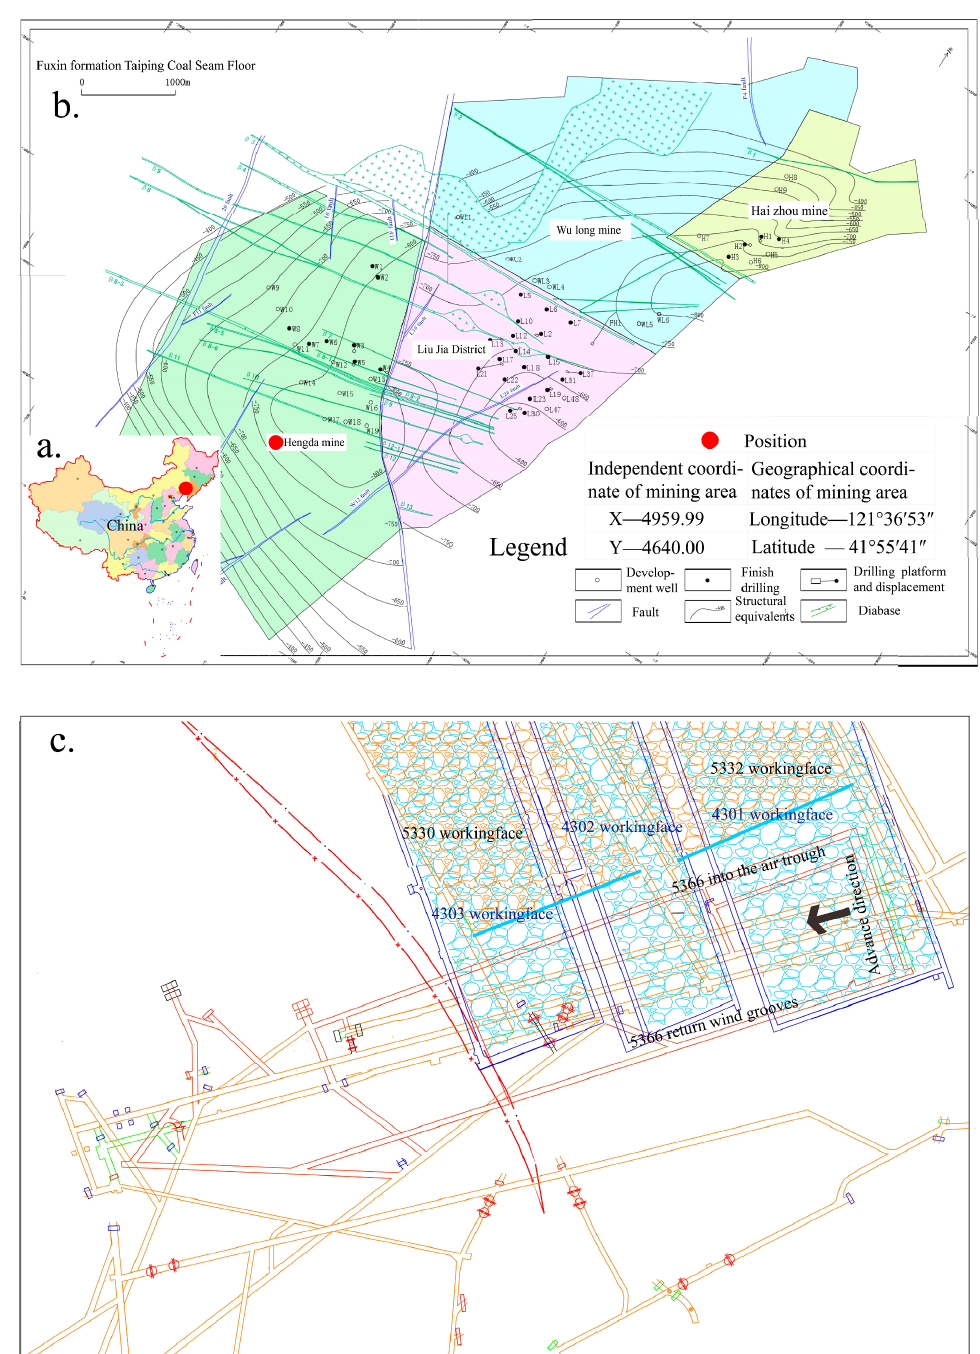
Figure 1. Geological information of Hengda coal mine. ( a ) Location of Hengda coal mine; ( b ) Geological boundary of Hengda coal mine; ( c ) Simplified layout of 5366 working